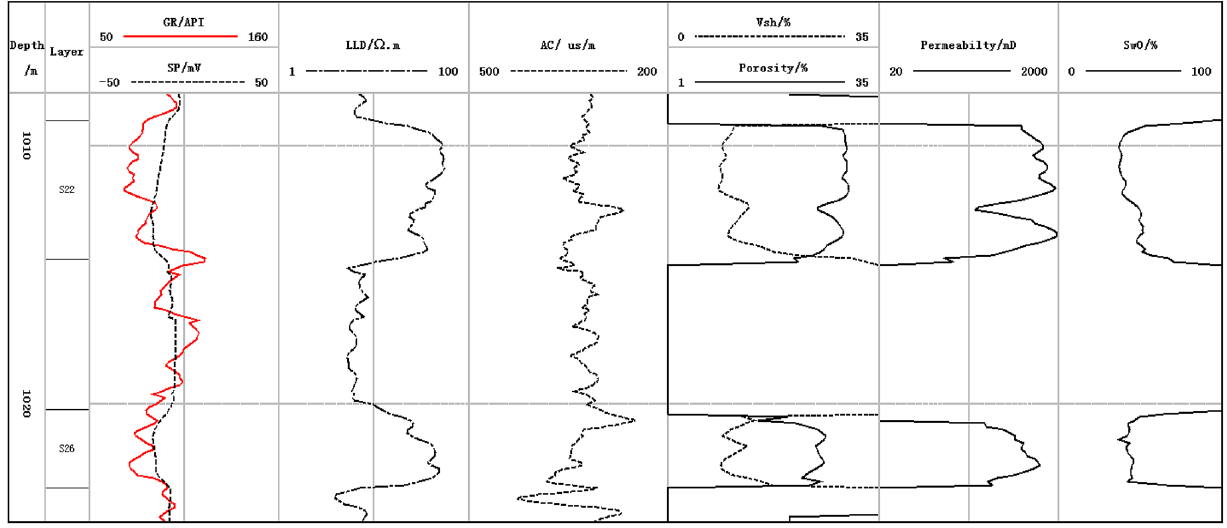
acoustic log, us/m; the fifth track is shale content curve V sh , %, and porosity 𝜑 , %; the sixth track is permeability k , mD; the last track is the saturation curve from well logs Sw 0 ,